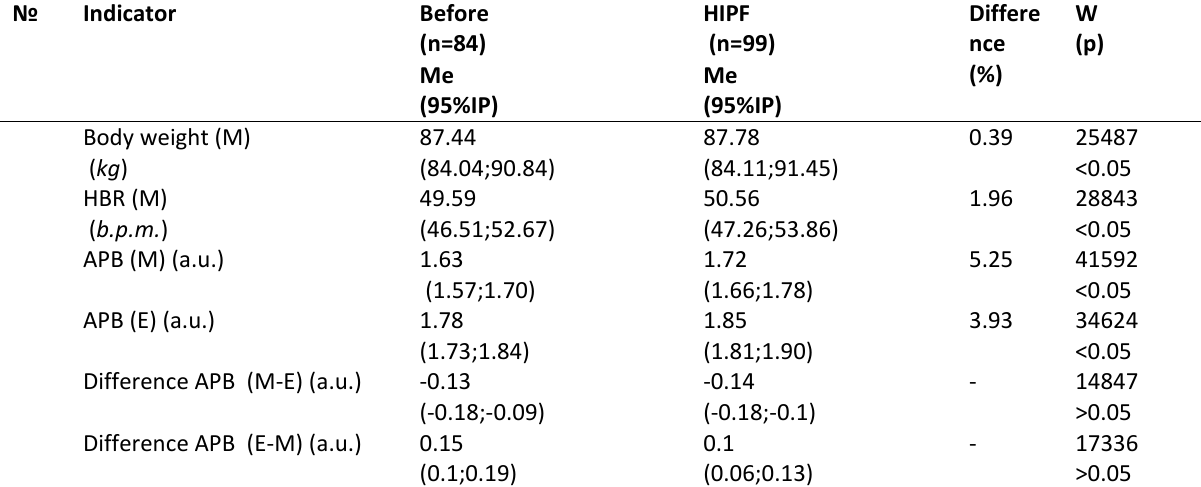
Table 2. Comparison of PC indicators before and in days of highly intensive physical functioning №